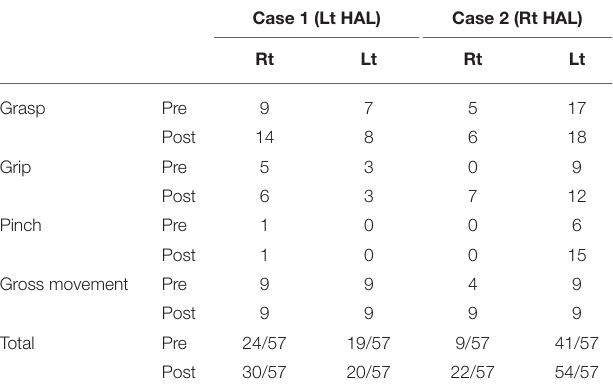
TABLE 2 | The results of ARAT before and after the HAL